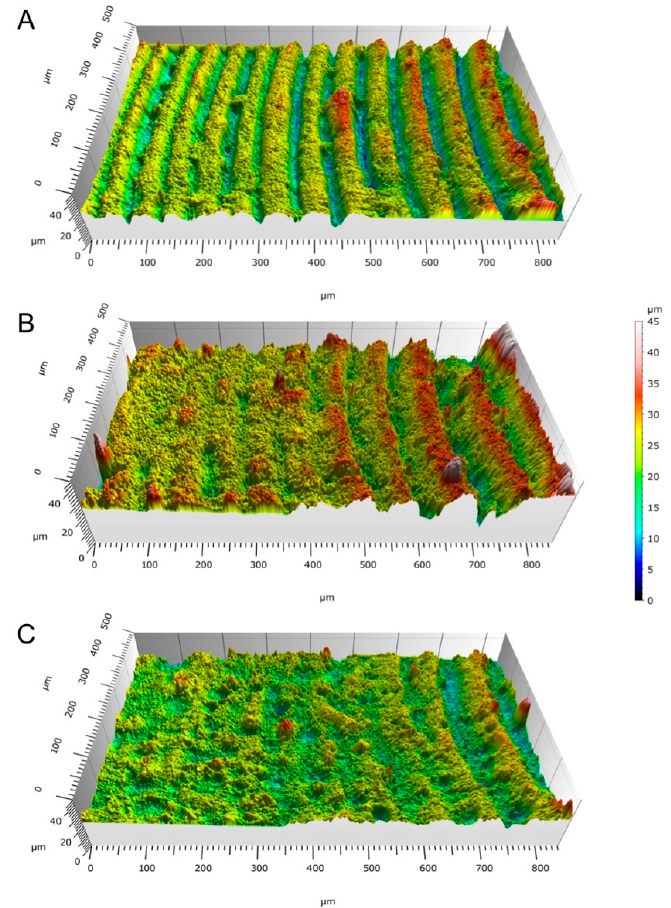
Figure 8. 3D point cloud maps of the surfaces of the 3 mm vat photopolymerization beads with ( A ) 0% HA, ( B ) 10% HA, and ( C ) 20% HA.